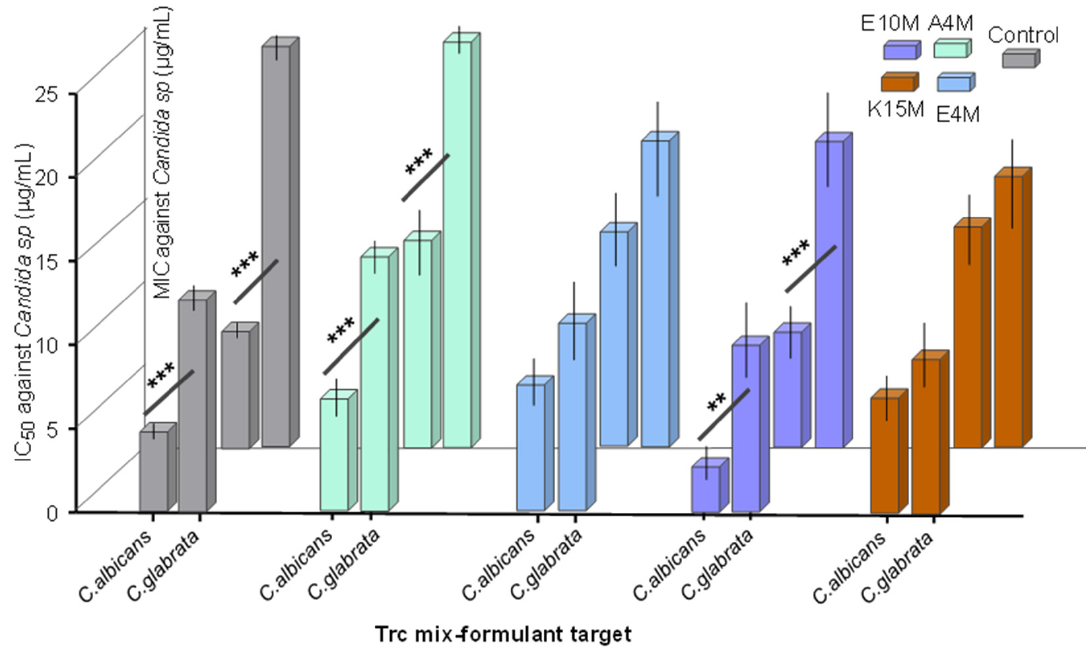
Figure 6. Comparison of the IC 50 µg/mL against C. albicans and C. glabrata of 20-h-matured preparations (1:4 ratio). Data represent the mean of 3 biological repeats and 6–14 technical repeats with SEM. Unpaired Student’s t-test was done on each of the analysed groups, with ** p < 0.01 and *** p < 0.001.